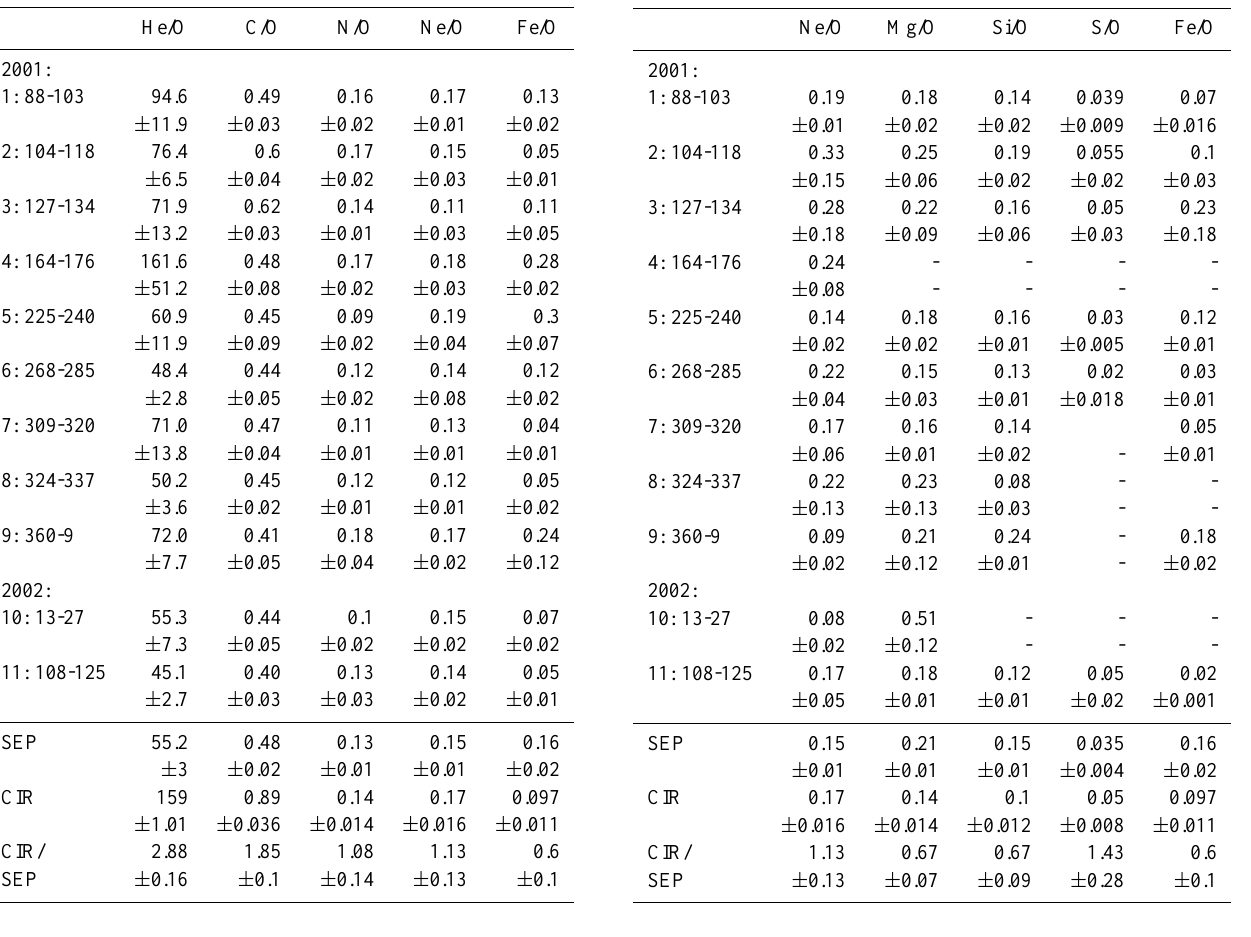
Table 2. The elemental abundance ratios averaged during 11 se- lected periods from the beginning of 2001 to day May in 2002 mea- sured by Ulysses COSPIN/LET in the higher energy range. The last six rows contain SEP and CIR values (Mason and Sanderson, 1999), the CIR/SEP ratios and their errors for comparison